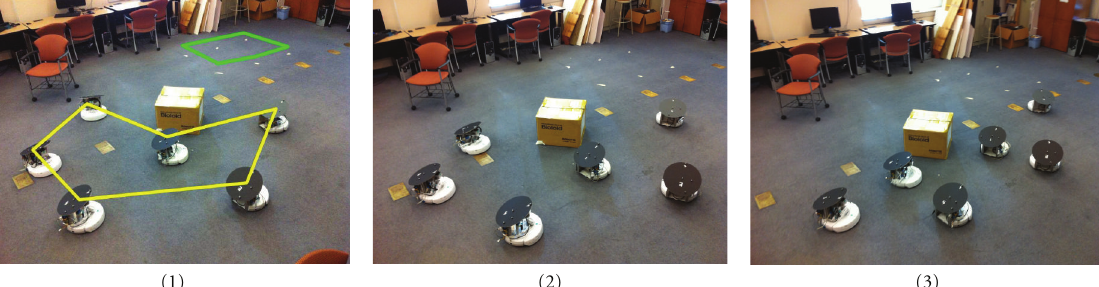
Figure 12: Three sequential snapshots of the 6 iRobot Creates executing the motion planner presented in this paper. The first frame show the connectivity ring and the goal positions.